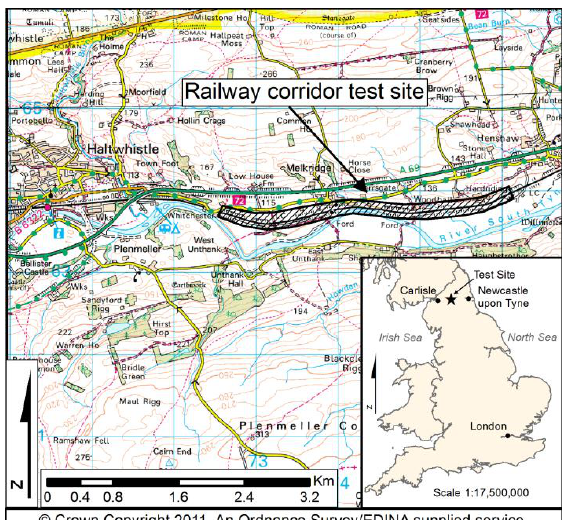
Figure 1. Location of railway test